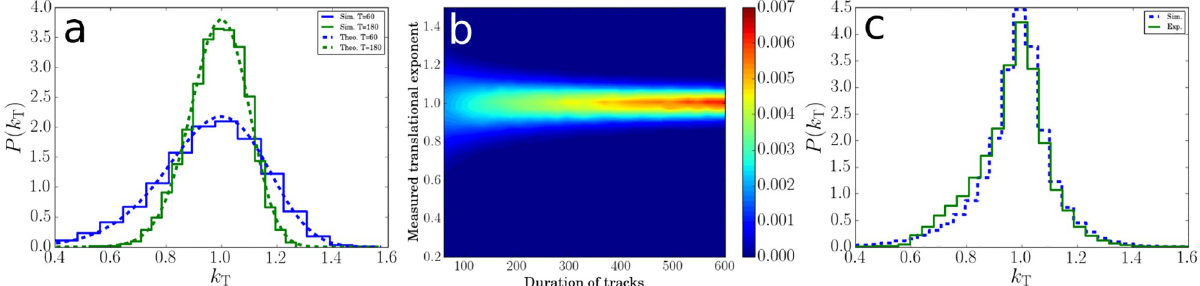
Fig 9. Distribution of the translational exponent for trajectories of diffusing cells. (a) , Probability distribution of the exponent k T for diffusers, from simulated tracks of specific duration ( T = 60 and T = 180 frames), compared with the theoretical result (Eq 9). The mean-squared displacements arising from the theoretical model assume calculations with non-overlapping time segments. To compare with theory (Eq 9), the simulation results in this figure have been calculated in the same way. (b) , Contour plot of probability to measure a certain translational exponent in simulations for different durations of a trajectory calculated using overlapping segments. Data is normalised such that the sum of probabilities for each trajectory duration (column) adds up to one. (c) , Probability distribution of the exponent k T for diffusers, from simulated tracks and from experiments for Δ FF and 0.2w% TWEEN 20. The simulated trajectories have the same durations as the trajectories from the experiments. The MSD from simulations in this figure have been calculated based on averages over overlapping segments, exactly as in the experiments.